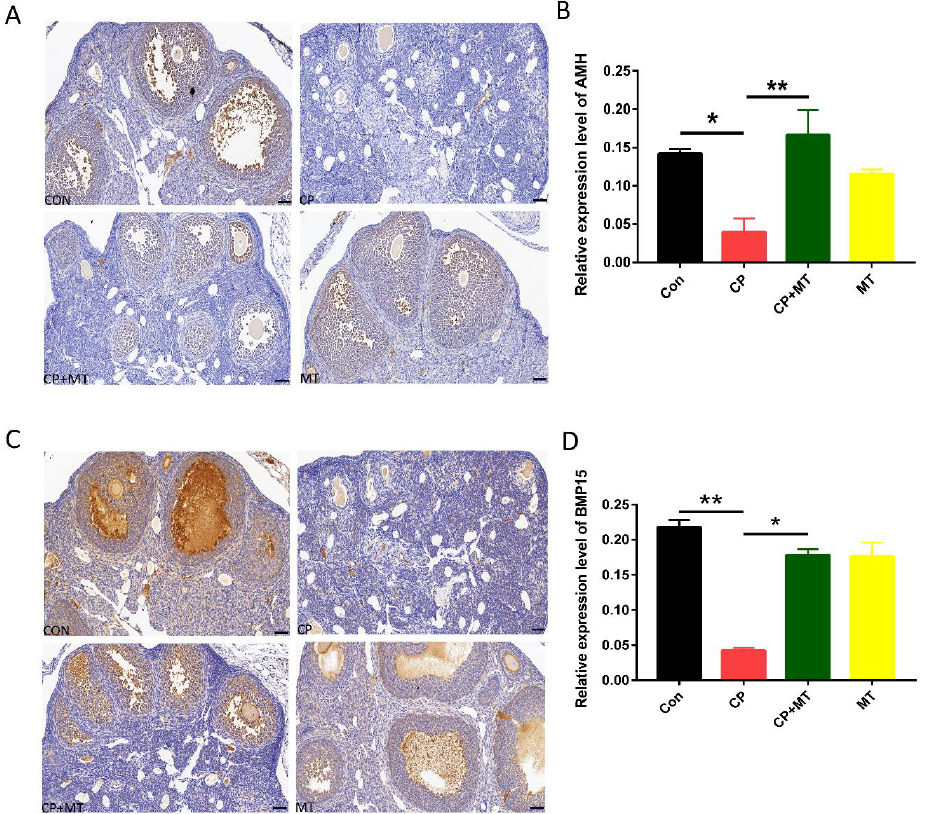
Figure 1. MT improved the expression of AMH and BMP15 after CP chemotherapy. ( A ) Images depicting AMH expression in ovary by immunohistochemistry in Con, CP, CP + MT, and MT groups. Bar = 50 µ m. ( B ) The expression level of AMH in ovary in the Con, CP, CP + MT, and MT groups ( n = 3). *, significant difference ( p < 0.05). **, significant difference ( p < 0.01). ( C ) Images depicting BMP15 expression in ovary by immunohistochemistry in Con, CP, CP + MT, and MT groups. Bar = 50 µ m. ( D ) The expression level of BMP15 in ovary in Con, CP, CP + MT, and MT groups ( n = 3). * significant difference ( p < 0.05). ** significant difference ( p <